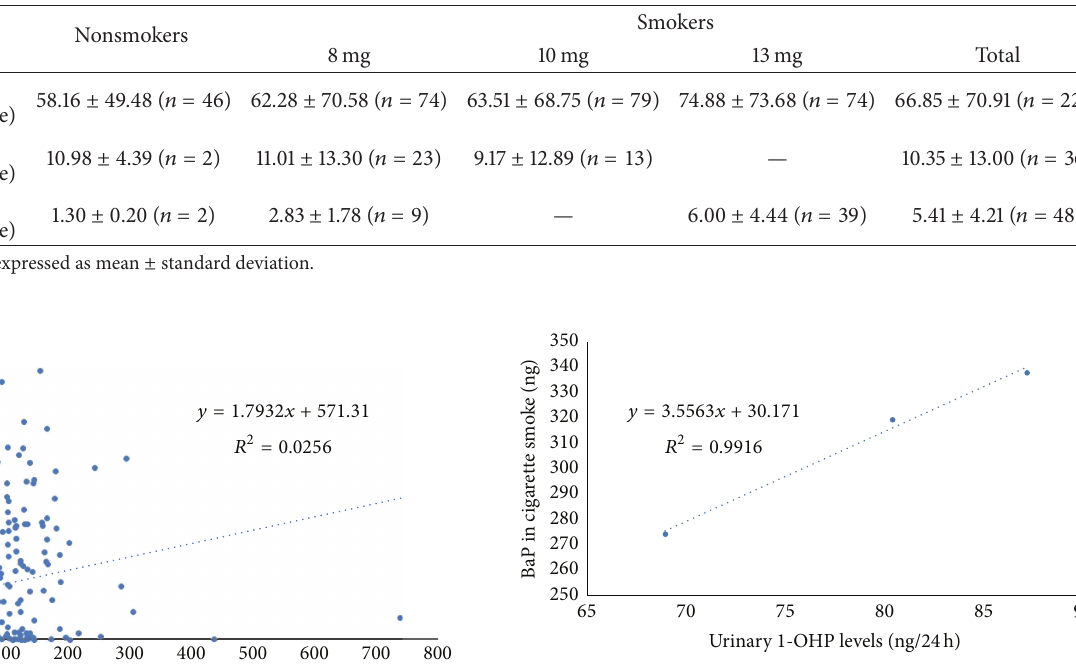
Table 4: Urinary 1-OHP, 3-OHBaP, and 3-OHBaA concentration after creatinine correction.